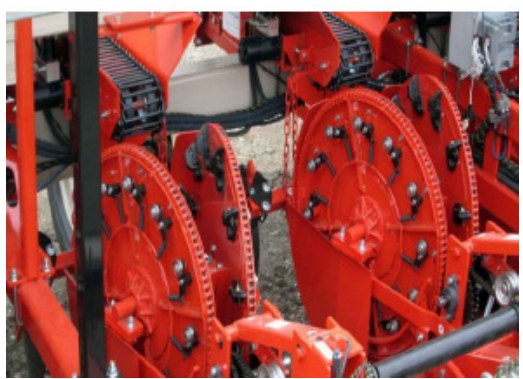
Figure 15. Lockwood 6200 Needle-type potato planter. Reprinted with permission from ref. [48] Copyright 2018 Lockwood Industries.